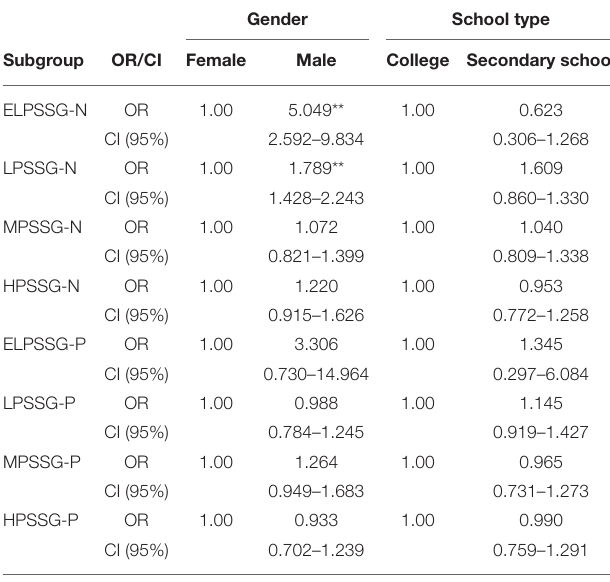
TABLE 3 | Latent profile and coping tendencies for different levels of perceived social support.